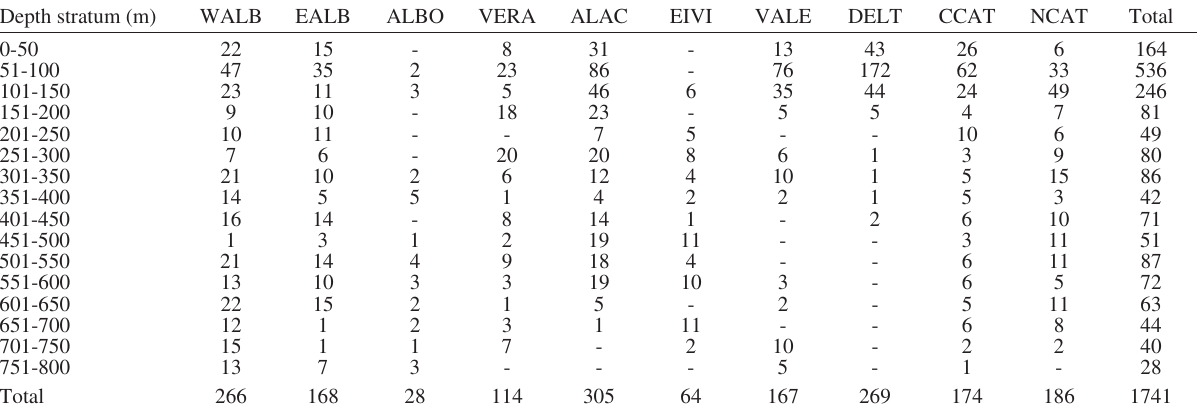
Table 1. – Number of hauls taken by depth stratum and geographic sector (1994-2008). Western Alboran (WALB); eastern Alboran (EALB); Alboran Island (ALBO); Vera Gulf (VERA); Alacant (ALAC); Eivissa Island (EIVI); Valencia (VALE); Ebro Delta region (DELT);